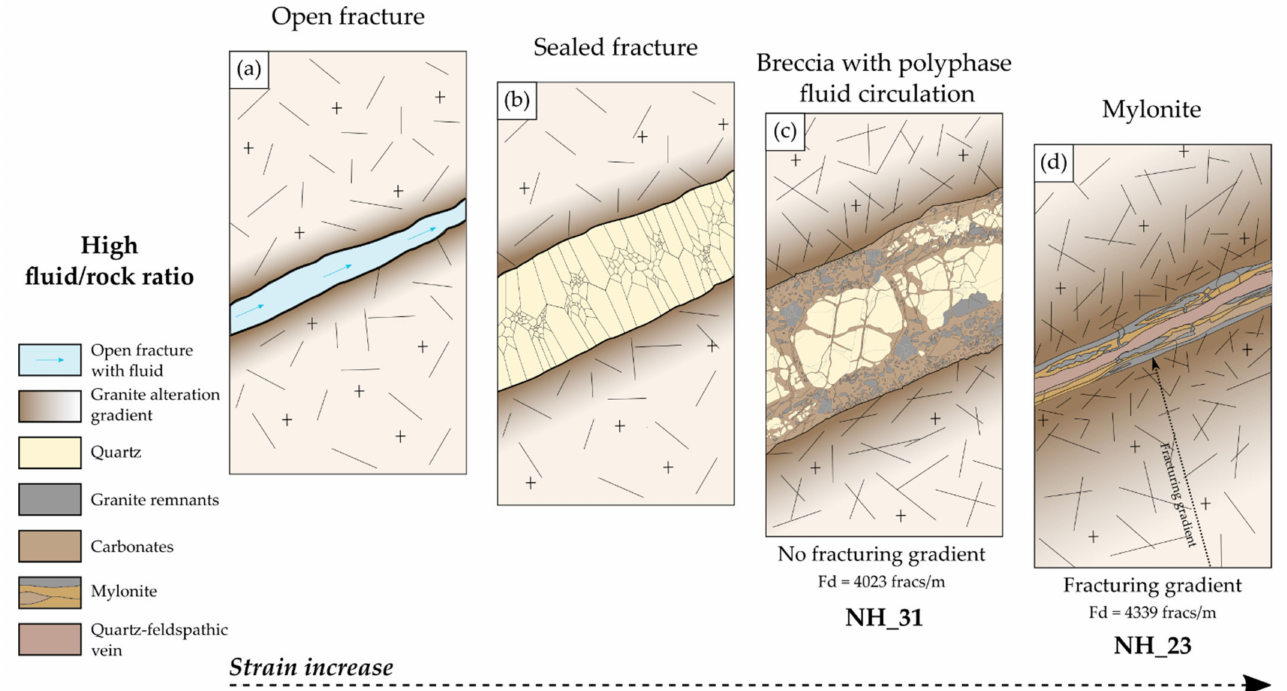
Figure 20. Synthetic scheme showing, from low to moderate strain, the interaction between the fluid and the granite in the cases of a high fluid/rock ratio observed in the field. ( a ) An open fracture with an incipient alteration gradient at the border. ( b ) A sealed fracture with a slight alteration gradient. ( c ) A brecciated vein induced from fracture reactivation and showing an alteration gradient, but no fracturing gradient. ( d ) A mylonite made of carbonates and granitic lenses showing an alteration gradient and a fracturing gradient. NH_31 and NH_23 show a similar fracture density (Fd). No scale is given for this scheme, because it can represent fracture zones of several order of